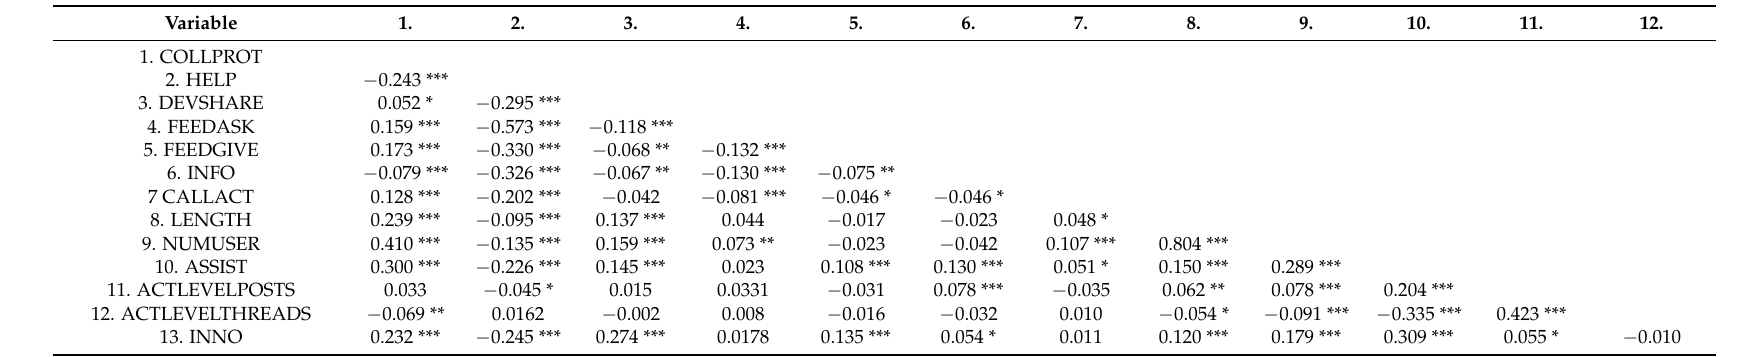
Table A1. Correlations (N =